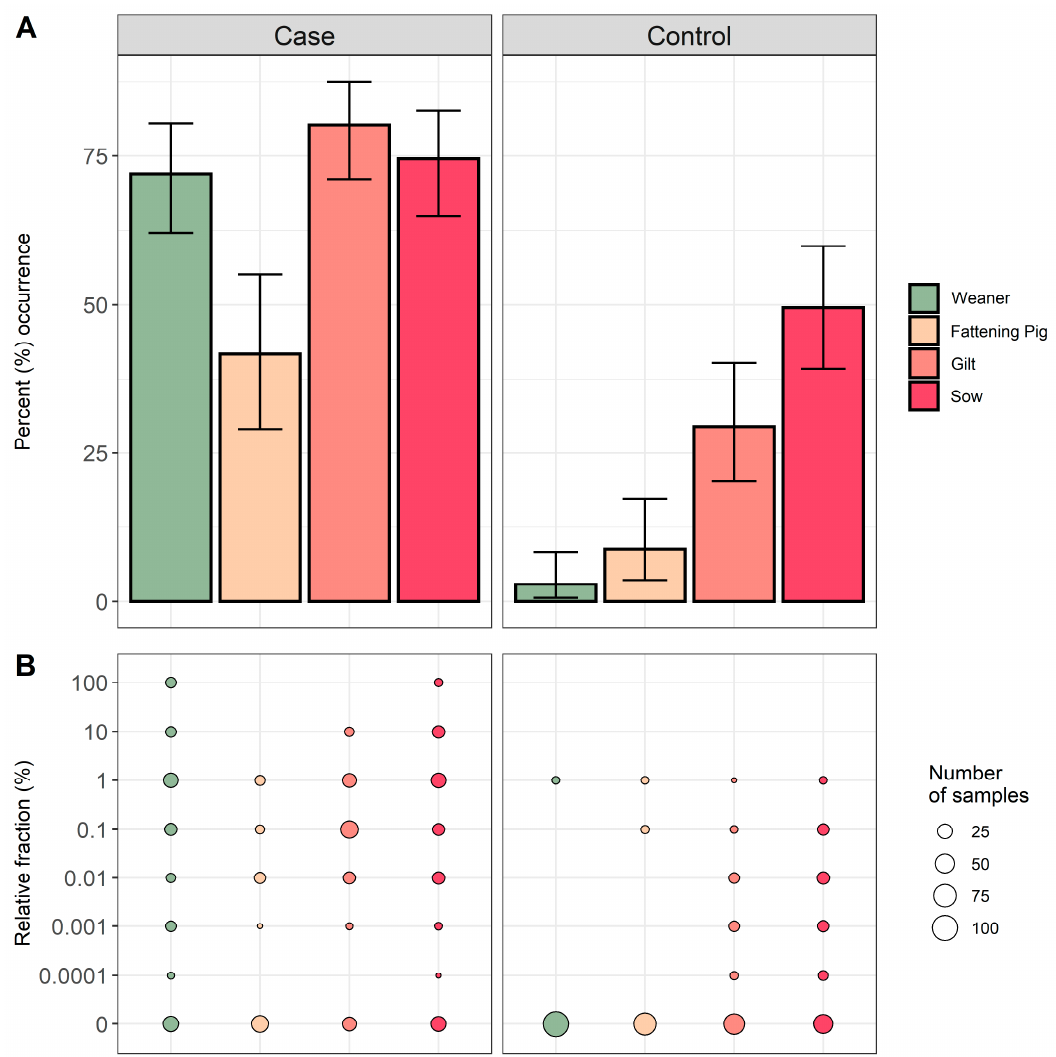
Figure 2. Occurrence and relative fraction of QREC among the tested samples from all four age groups. The colours denote the four different age groups included; weaners (green), fattening pigs (yellow), gilts (light red), and sows (dark red). Plot A presents the percent occurrence of QREC with 95% confidence intervals. Plot B represents the relative fraction of QREC among the total E. coli in the samples. The point size represents the number of samples with the respective QREC fraction.